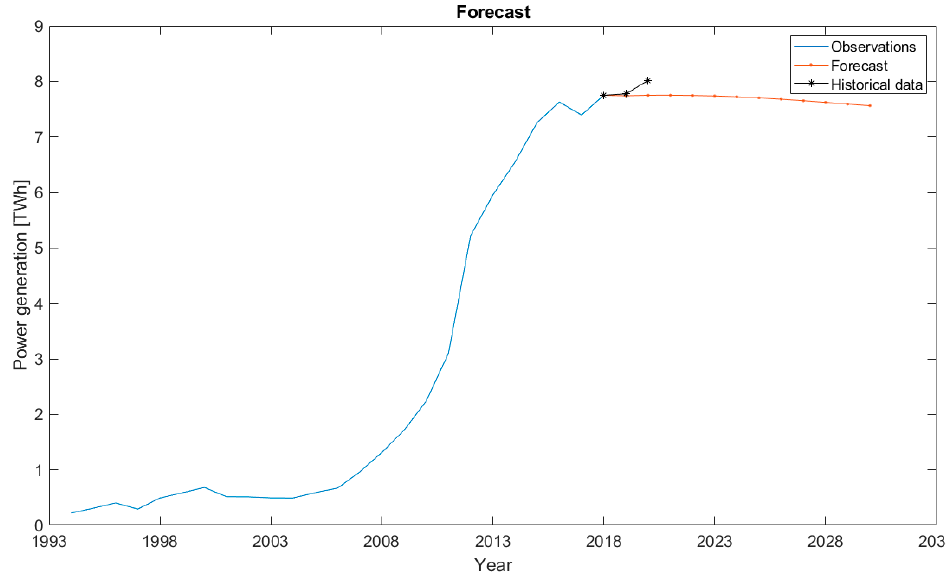
Figure 10. Prediction for possible future renewable energy production.